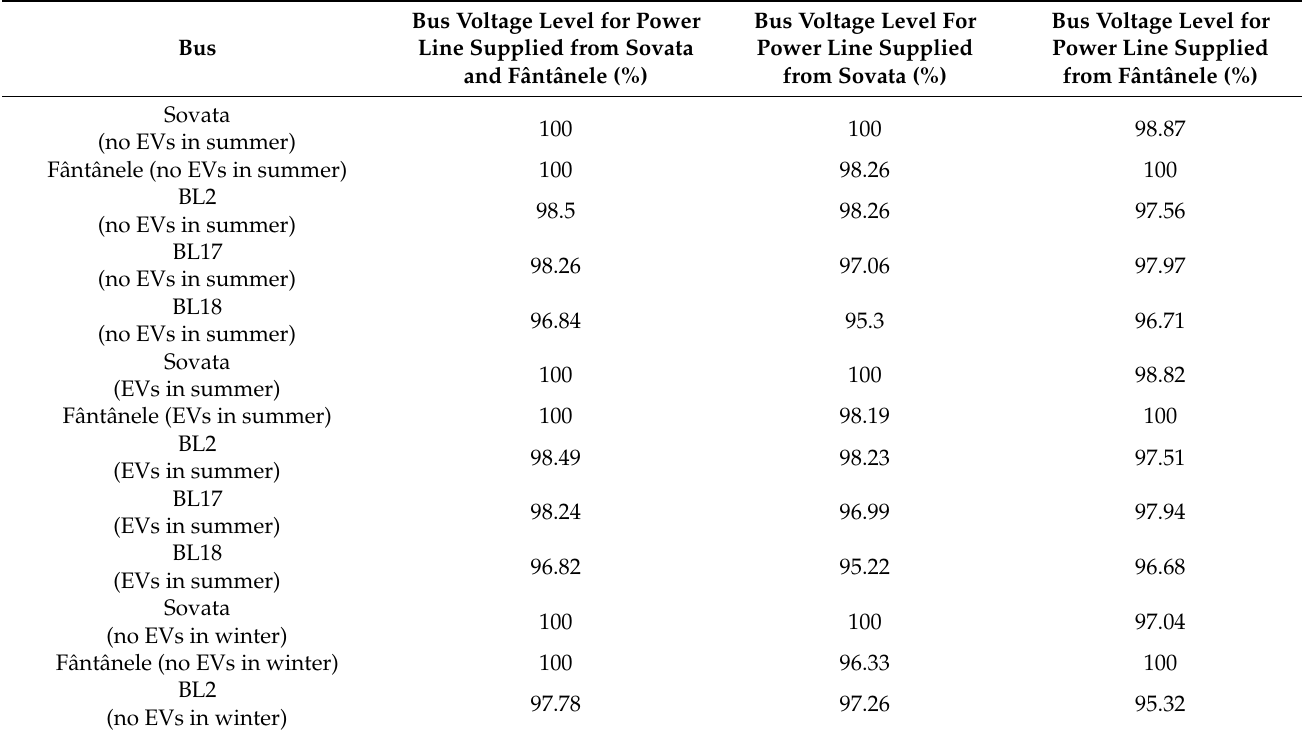
Table 23. Voltage level at 13:00 (scenario